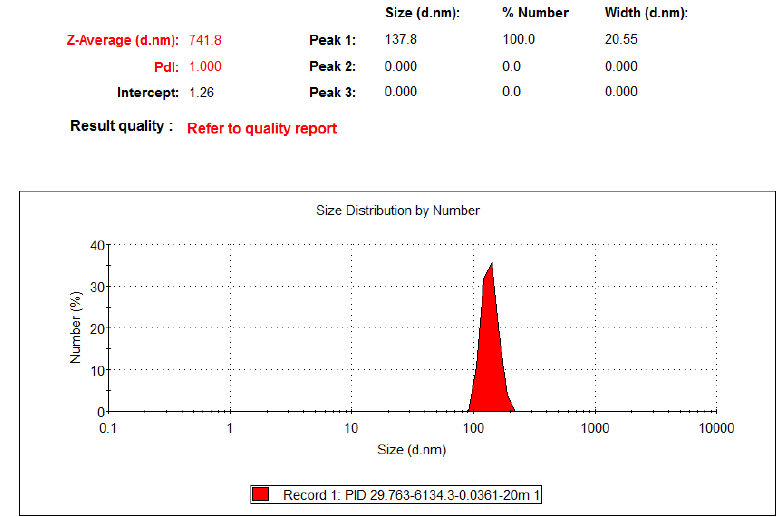
Figure 8. Particle size distribution of TiO 2 colloids produced by the PID-M1 controller.